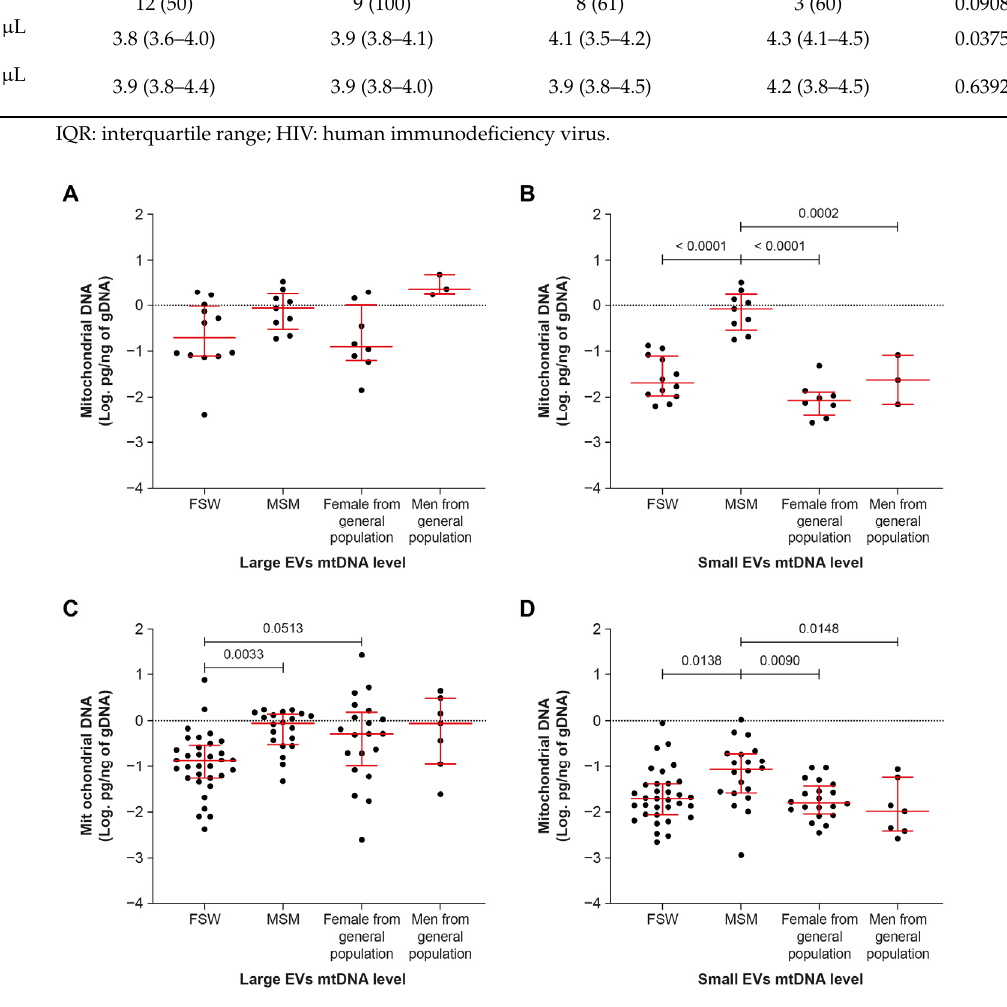
Figure 5. Mitochondrial DNA abundance in large and small EVs in viremic ( A , B ) and non-viremic ( C , D ) Tenofovir-treated participants. FSW—female sex workers, MSM—men who have sex with men. In graphs, the dots represent individual value and lines the geometric mean with geometric standard deviation factor. An ordinary one-way ANOVA with Tukey’s multiple comparisons test was used to reveal significant differences between groups.